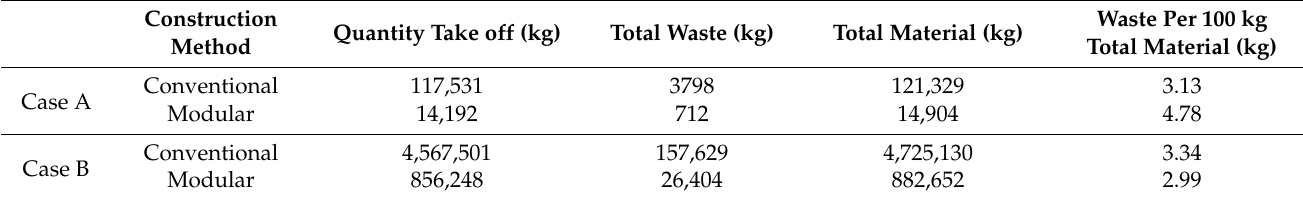
Table 10. Comparison of modular and conventional waste generation per 100 kg of total